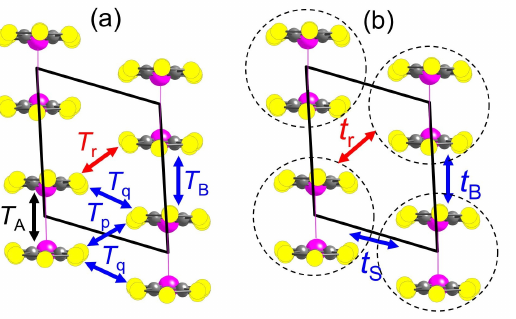
salts showing 2